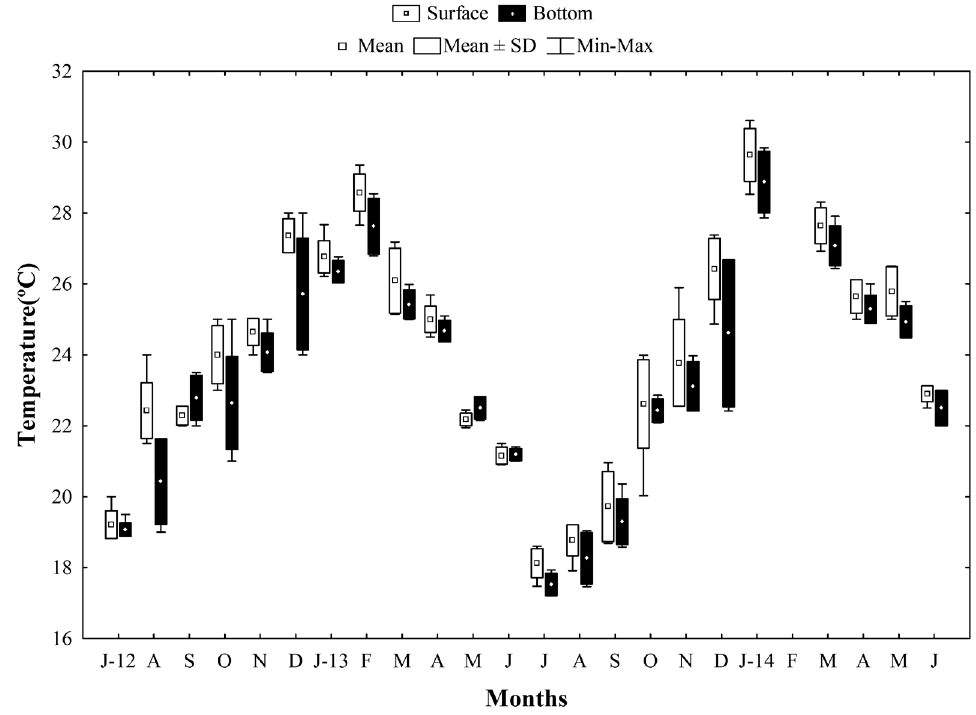
Figure 2. Temporal variation of temperature of surface and bottom water, from July/2012 to June/2014, in Cananéia region, Brazil (Mean; SD = standard deviation; Min = minimum; Max =